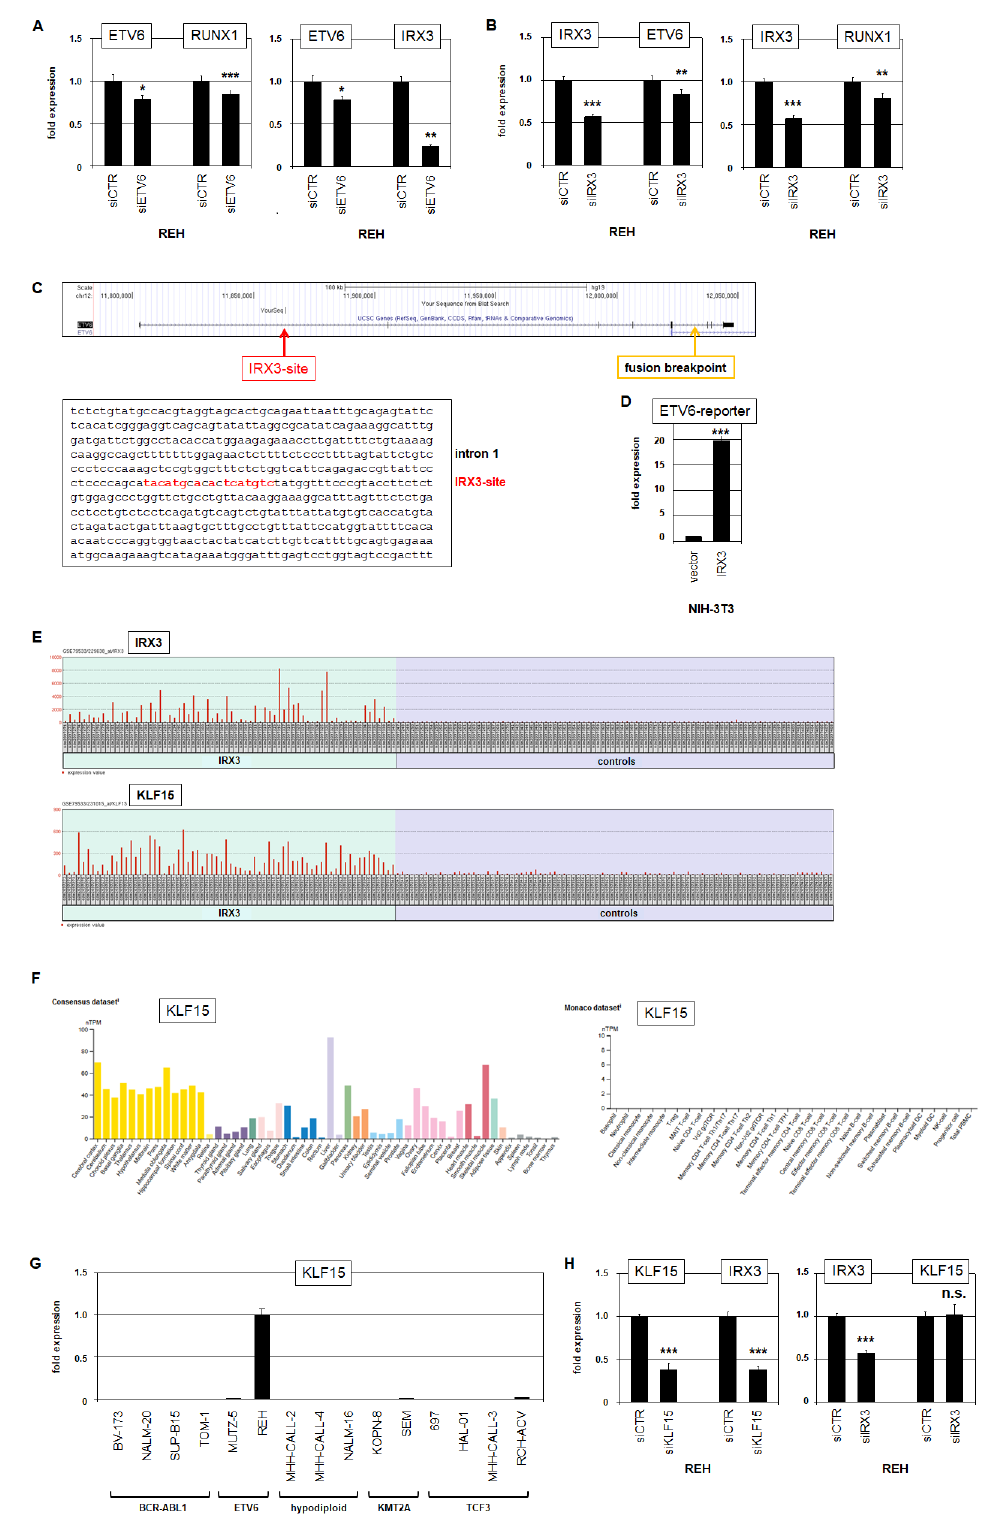
Figure 5. ETV6 and KLF15 are targets and regulators of IRX3. RQ-PCR analysis of REH cells treated for siRNA-mediated knockdown of ( A ) ETV6 and ( B ) IRX3. ( C ) Gene map and genomic sequence derived from the genome browser UCSC for the gene ETV6. A potential binding site for IRX3 is indicated in red (located in intron 1); the breakpoint for fusion gene ETV6::RUNX1 is indicated